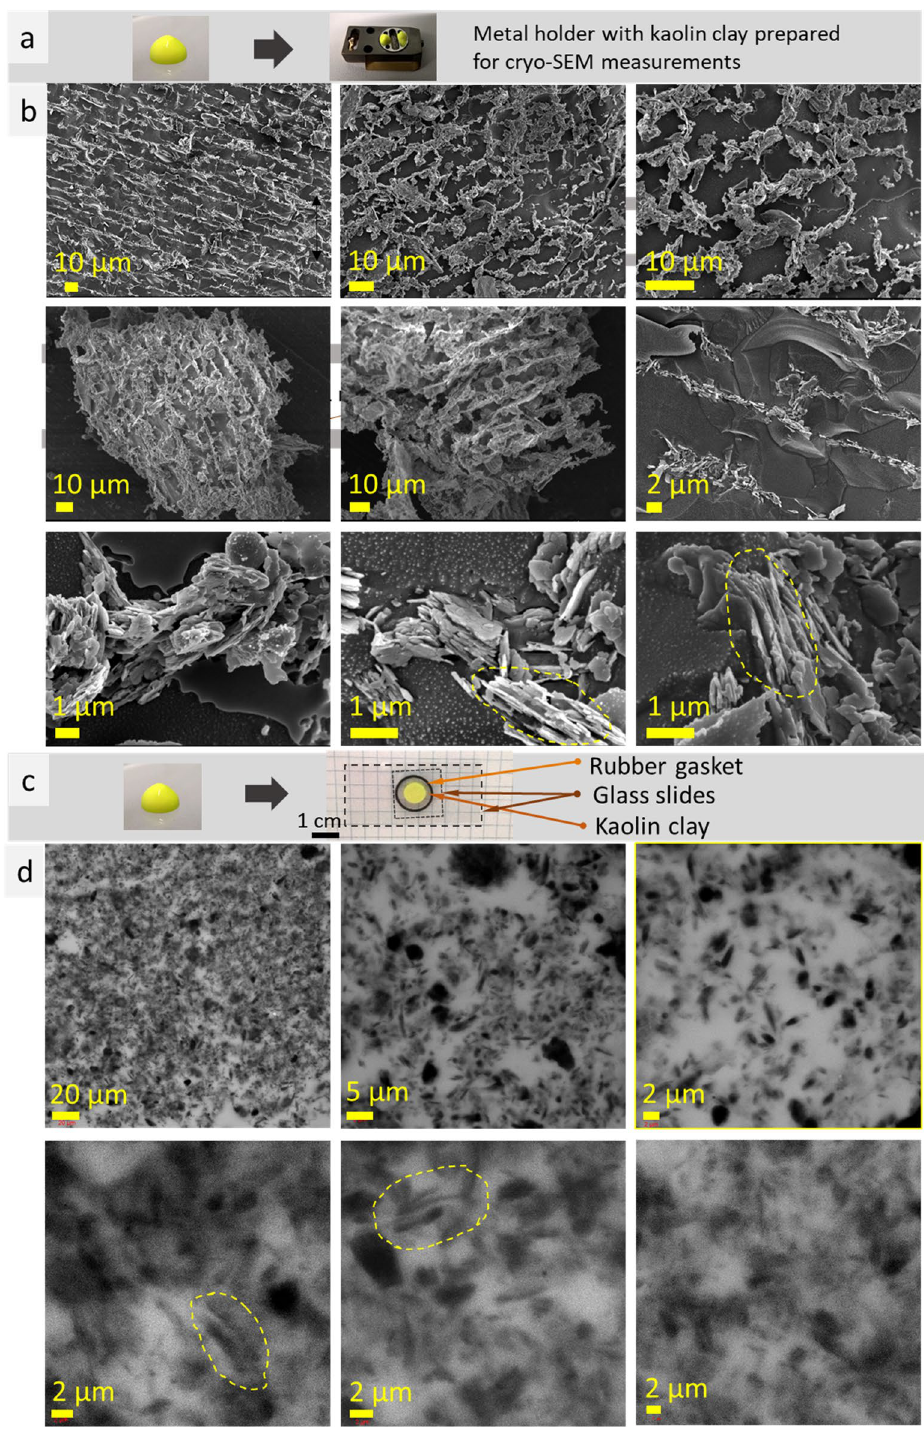
Figure 5. Photos of a drop of kaolin clay with fluorescein and specimen shuttle with kaolin clay in an aluminum holder prepared for nitrogen slush plunge-freezing ( a ), cryo-SEM images of kaolin clay with fluorescein ( b ). Photos of kaolin clay with fluorescein, glass slides with rubber gasket with kaolin clay between them for confocal LSM imaging ( c ); confocal LSM images obtained at excitation wavelength 405 nm, laser power 0.002 mW (light—kaolin, dark—water). Examples of parallel alignment of kaolin microplates are outlined in yellow dashed lines ( d